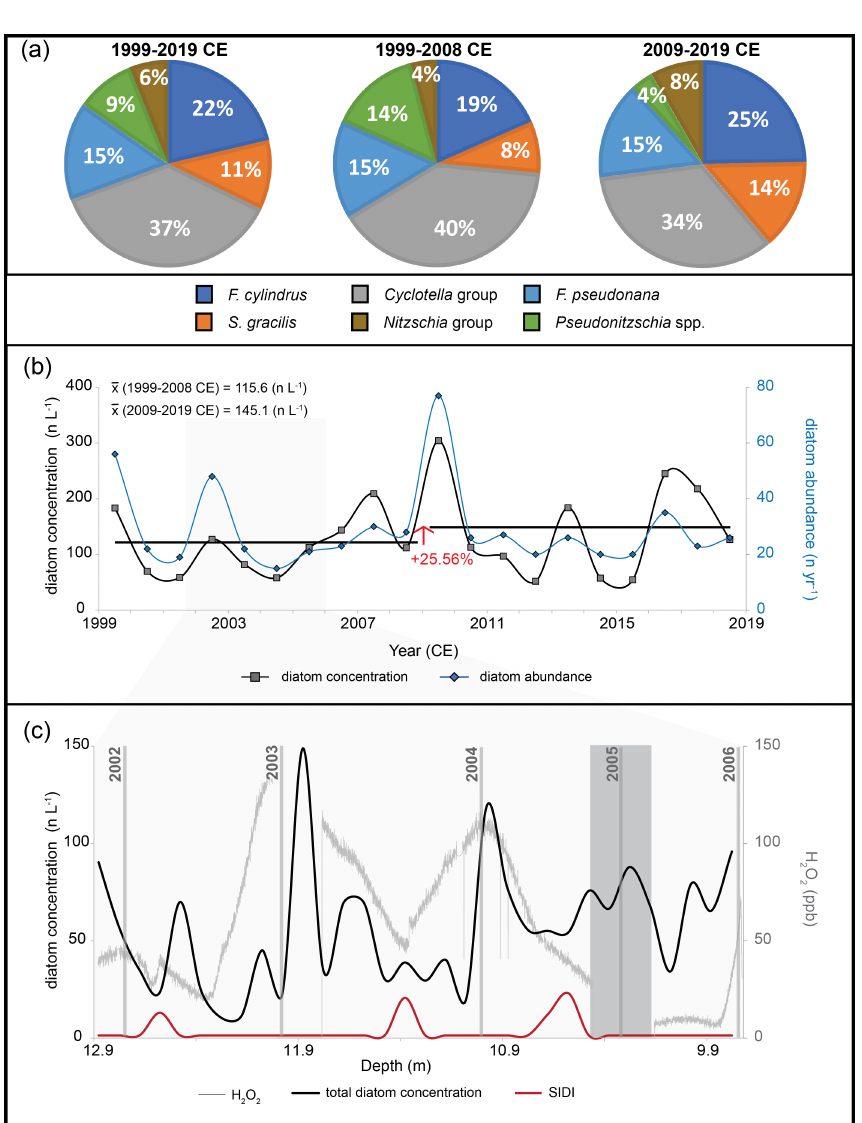
Figure 3. Diatom record from the SKBL ice core. (a) Main diatom assemblage composition of the SKBL ice core during 1999–2019CE and during decadal subsets. Percentages reported in this figure were normalized to the main species identified. (b) Diatom concentration and diatom abundance time series. The red arrow represents the percentual variation in the diatom concentration decadal mean. (c) Total diatom concentration and SIDI variations down-core for the 2002–2006CE horizon. Vertical grey lines indicate temporal horizons based on the austral summer maxima in H 2 O 2 . The vertical grey band indicates a gap in the H 2 O 2